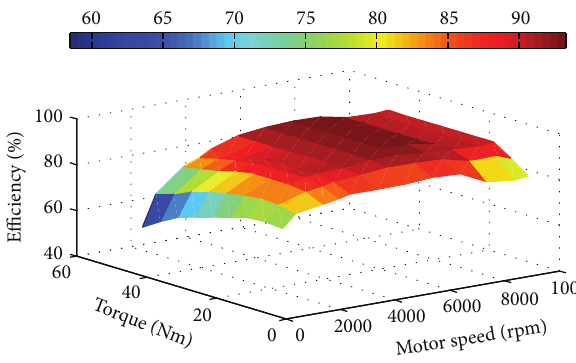
Figure 4: The efficiency map of the motor.